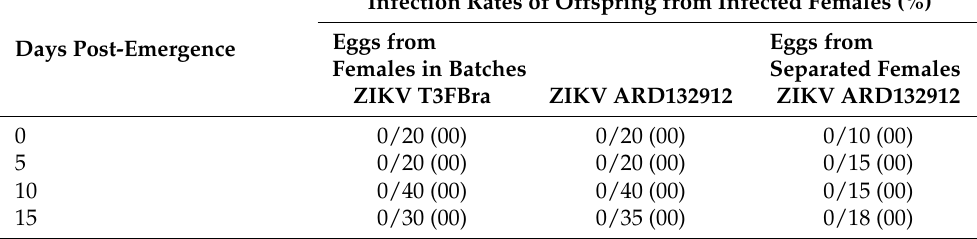
11/13 (84.6) Separated females NA 20/22 (90.9) Total 12/63 (19.04%) 70/85 (82.35%) Table 5. Infection rates of A. aegypti offspring from females infected with the Senegalese and Brazilian strains of ZIKV at different days after emergence. Infection Rates of Offspring from Infected Females (%) Eggs from Eggs from Days Post-Emergence Females in Batches Separated Females ZIKV T3FBra ZIKV ARD132912 ZIKV ARD132912 0 0/20 (00) 0/20 (00) 0/10 (00) 5 0/20 (00) 0/20 (00) 0/15 (00) 10 0/40 (00) 0/40 (00) 0/15 (00) 0/30 (00) 0/35 (00) 0/18